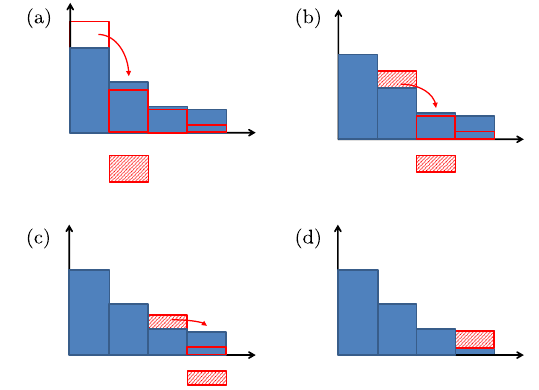
FIG. 5. The heights of each column are given by the probability of being in a particular eigenstate. The action of T transforms transforms an initial state represented by red columns into the state represented by blue columns. The probabilities (column heights) of the red state majorize those of the blue state. We work our way from left to right, moving probability mass from the red histogram to the right until it matches the blue histogram. In each step we move some probability mass from a column of the histogram of the initial state and move it to the right either until it matches the probability required of the target state or until the left column of the initial state matches the right column of the final state. Red dashed rectangles represent the part of the column that is added to the next one due to the action of the T